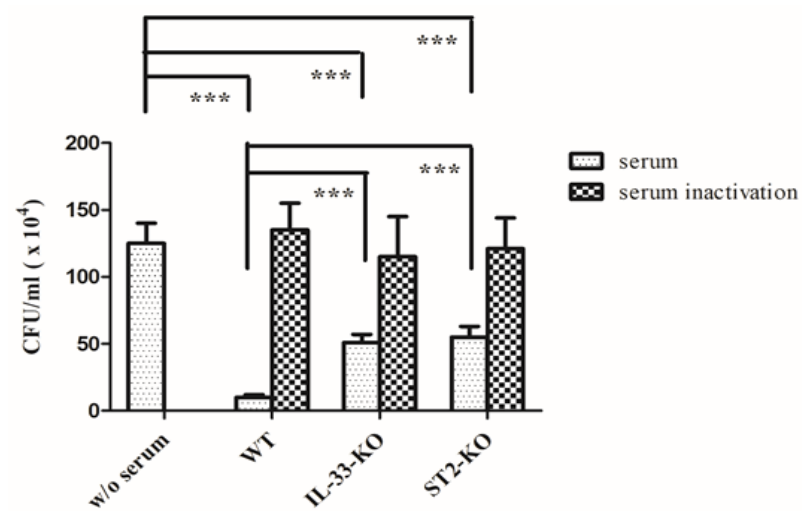
Figure 5. Serum killing activity against GAS. Sera collected from WT, IL ‐ 33 ‐ KO and ST2 ‐ KO mice were diluted 2 ‐ fold with PBS, then incubated at 4 °C or 56 °C for 30 min, and then were cultured with 1.5 × 10 4 CFU of GAS (NZ131) for another 2 h. At the indicated time, bacteria were quantitated by plate counting. One of three experiments is represented, and the results are expressed as the mean ± standard deviation. Treatment groups were compared for significance using ANOVA. *** p < 0.001, compared with the relative group as shown in the figure.